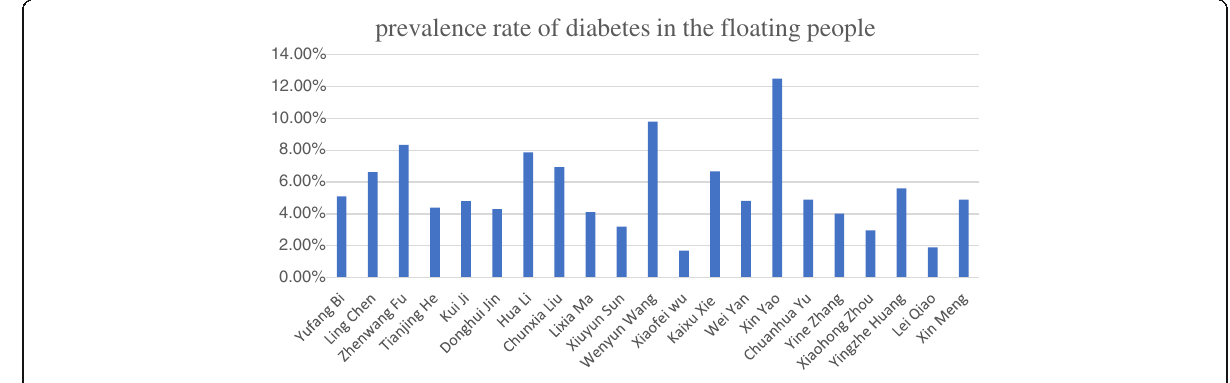
Fig. 1 The prevalence rate of each